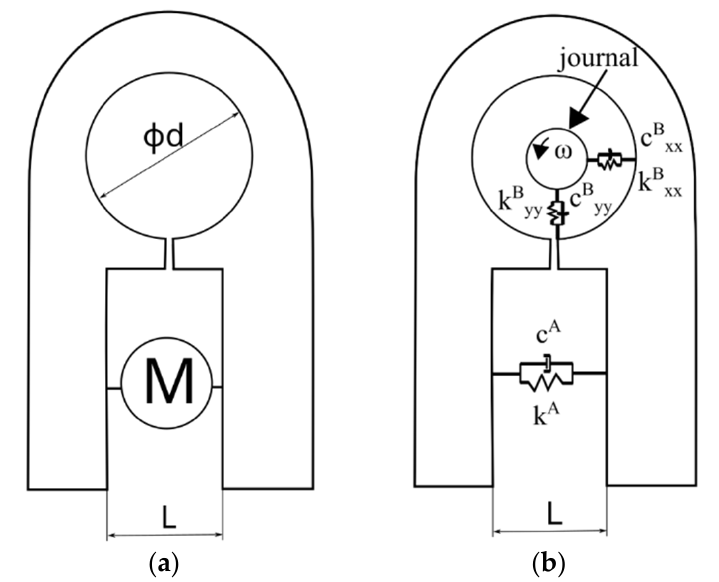
Figure 1. ( a ) Schematic of the active foil bearing; ( b ) Examples of discretization of degrees of freedom (in the direction of x and y respectively we obtain stiffness and damping parameters—k B xx, k B yy, c B xx, c B yy) and parameters of actuators (in the direction of the actuator, we obtain parameters like k A , c A , speed of changes, acceleration of